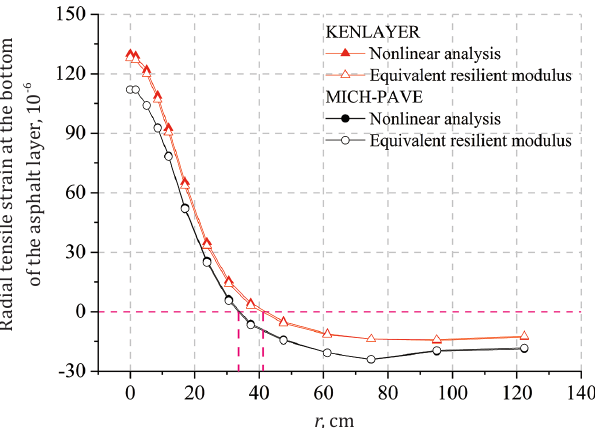
Figure 14. The distribution of the radial strain on the bottom of the asphalt